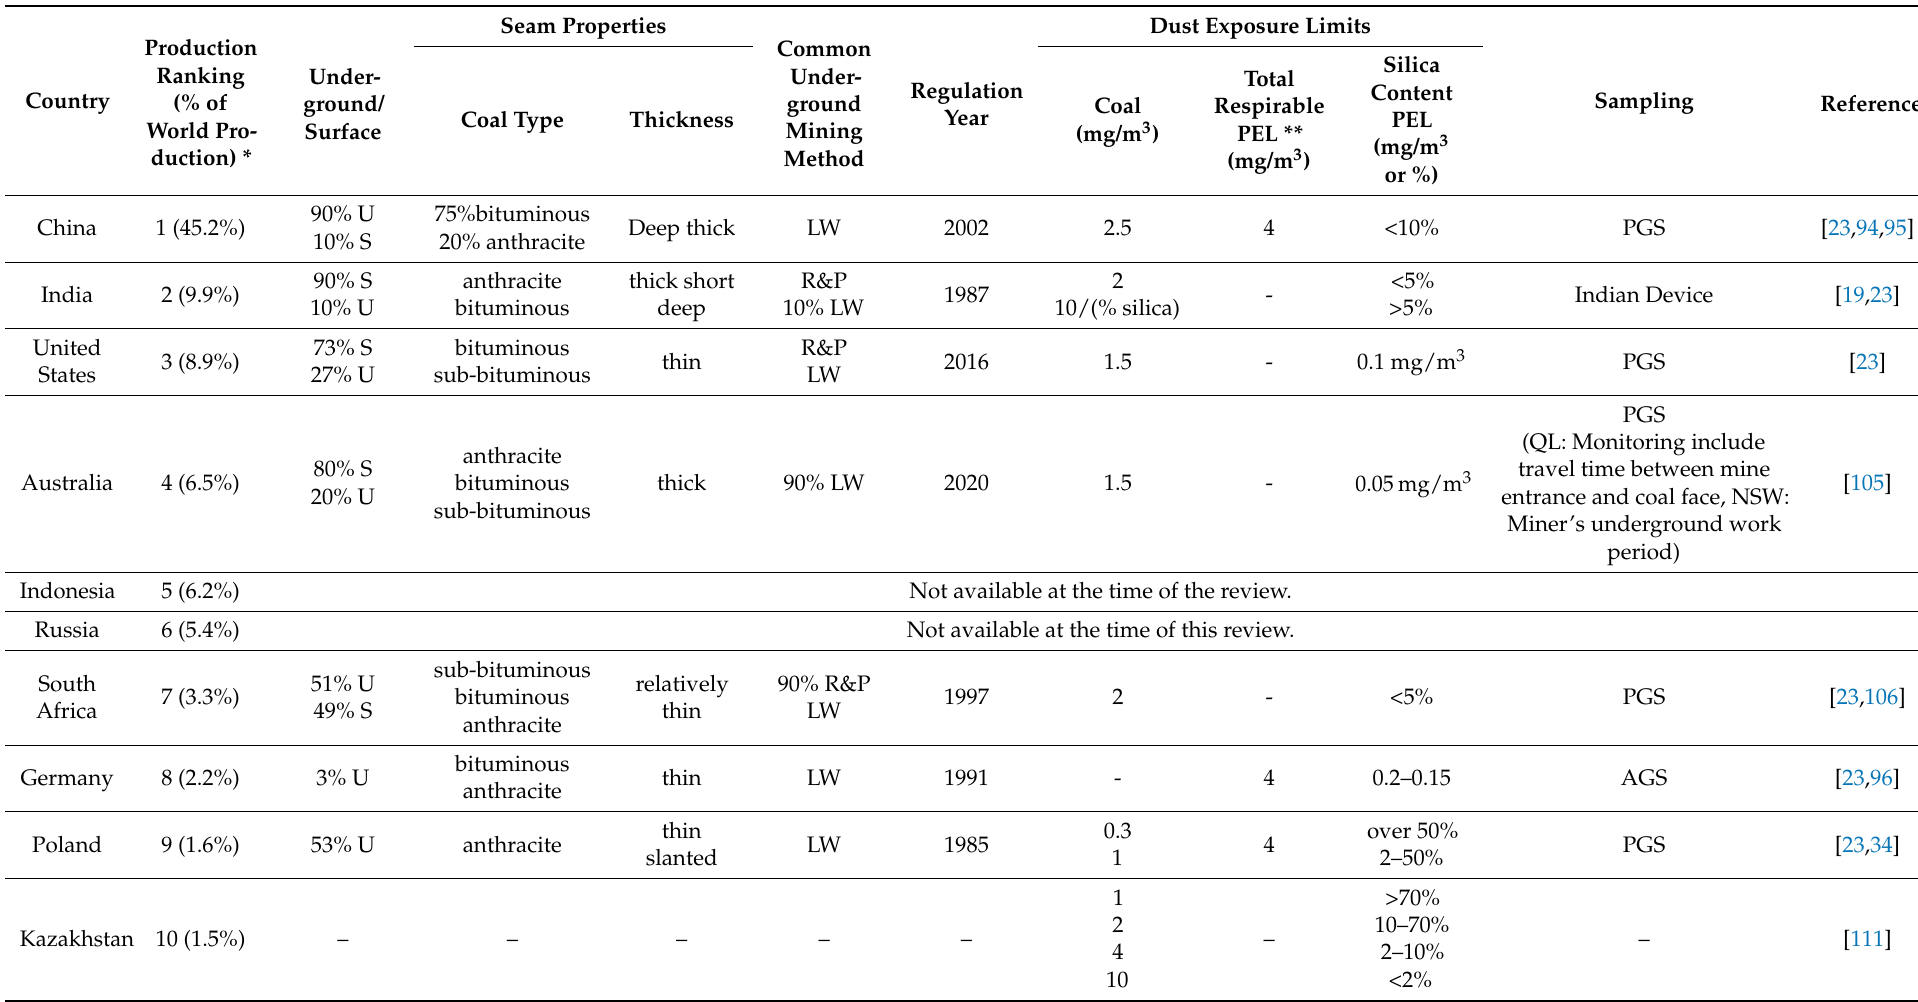
Table 2. Top 10 coal producers in the world with a dust exposure